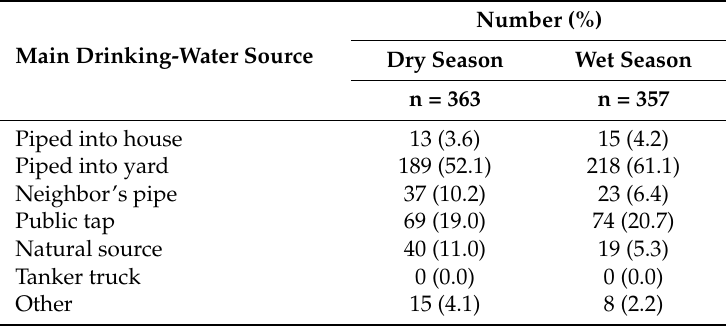
Table 2. Primary drinking-water sources reported among 363 and 357 households in the study area in the dry and wet seasons,